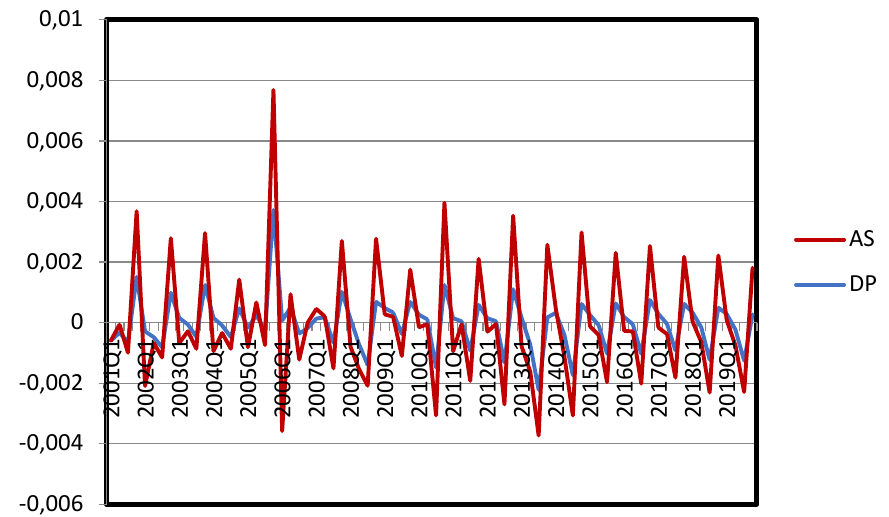
Figure 2. Automatic Fiscal Stabilisers (AS) and Discretionary Fiscal Policy